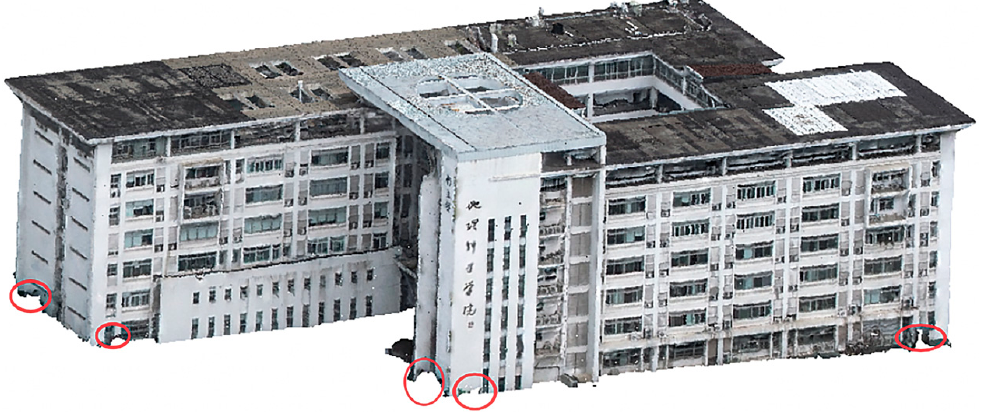
Figure 1. Example of a building point cloud (red circles represent the location of holes).